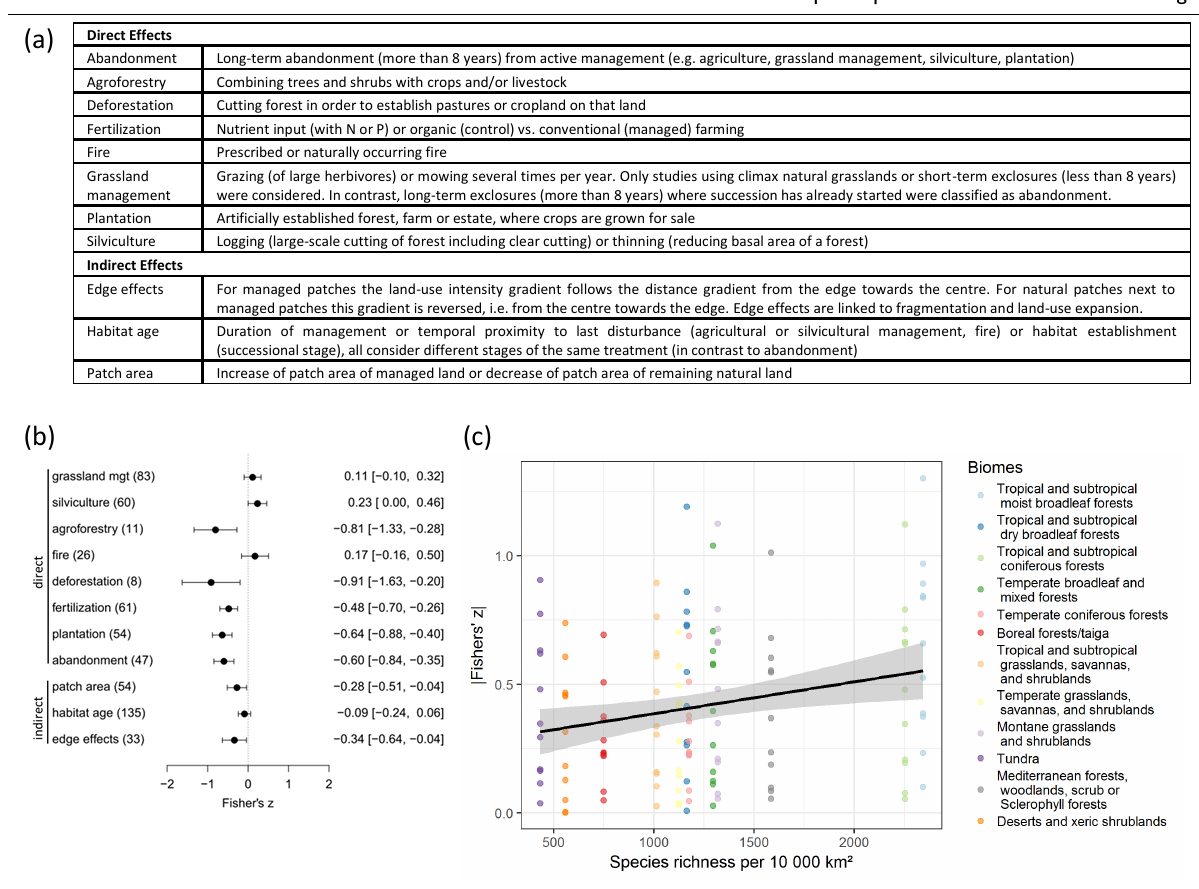
Figure 3. (a) Land-use classes considered and their definitions used in the meta-analysis of Gerstner et al. (2014b). (b) Effect-size plot from the linear mixed-effects model considering land-use classes as fixed effects. Dots and bars represent mean effect sizes and their 95% confidence interval as estimated from the model. Effect sizes indicate the direction and magnitude of the effect of land use on plant species richness. Positive or negative effect sizes indicate whether land use is associated with increases or decreases in species richness, respectively. Number of study out- comes is given in brackets. (c) Relationship between species pool size, as estimated by the biome-specific SAR per 100 km x 100 km (cf. Fig. 2b), and absolute effect sizes per land-use class in biomes. Species pool size is positively correlated with land-use effects in biomes ( r =0.234, P = 0.007). Figures reproduced with publisher’s permission from Gerstner et al.